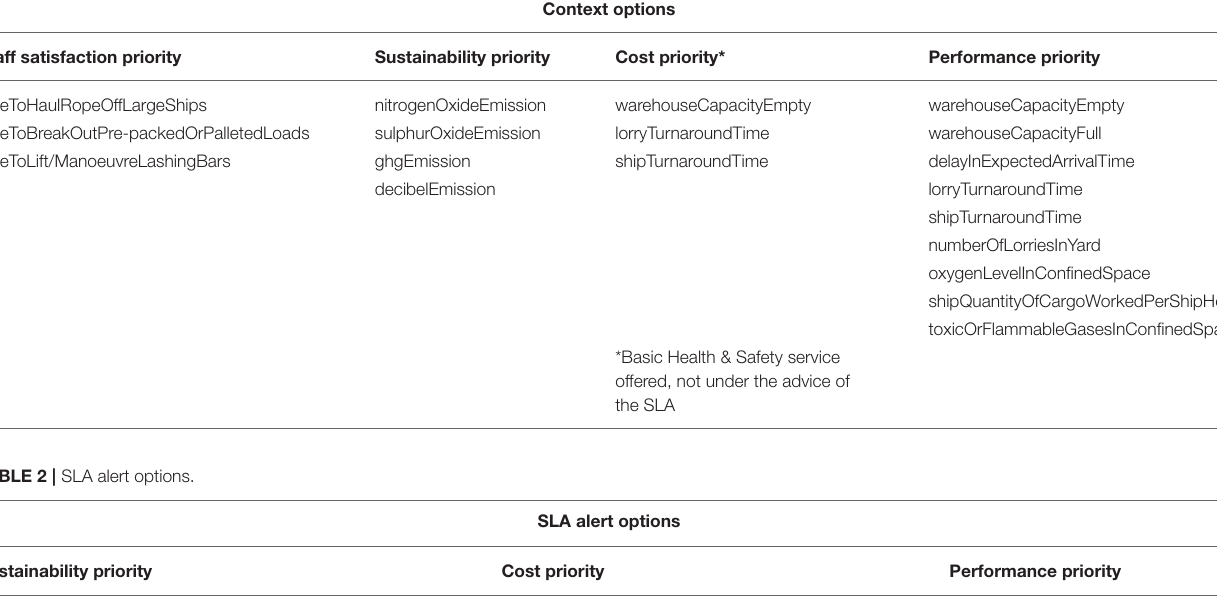
TABLE 1 | Context metrics collected per SLA priority.